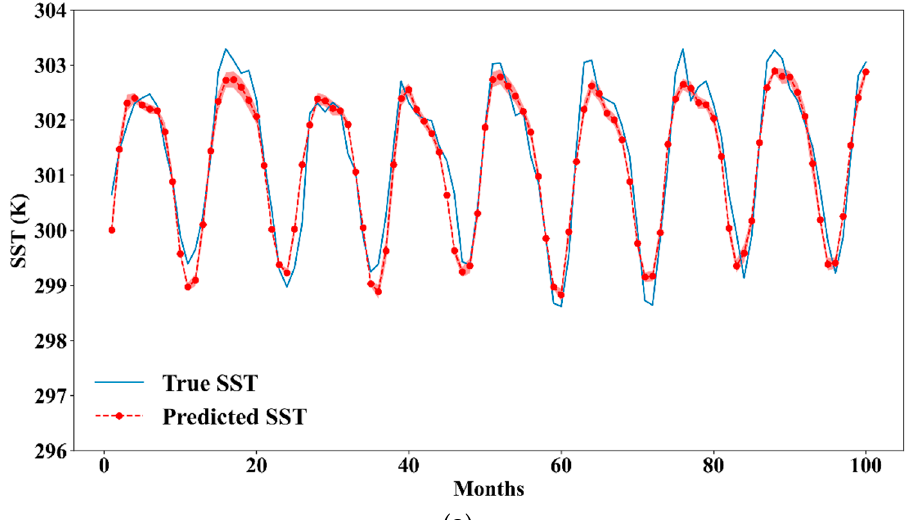
Figure 12. SST prediction results of the sea areas around China ( a ) Bohai Sea and north part of Yellow Sea, ( b ) South part of Yellow Sea, ( c ) Part 1 (ID:3 in Table 1) of East China Sea, ( d ) Part 2 (ID:4 in Table 1) of East China Sea, ( e ) Part 1(ID:5 in Table 1) of Taiwan Strait, ( f ) Part 2(ID:5 in Table 1) of Taiwan Strait and ( g ) South China Sea.